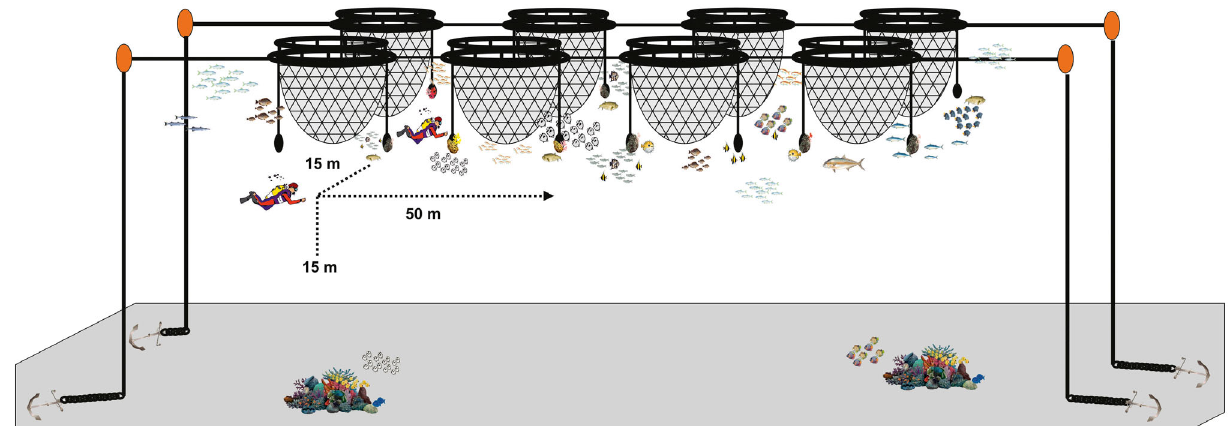
Fig. 2. Sketch showing 2 divers carrying out the underwater rapid visual census around fish cages at depths of 5 to 12 m, with the water column scanned from surface to bottom of adjacent cage (extension of census volume indicated). The sandy seafloor in this area has few solid substrates (e.g. concrete moorings or debris associated with the fish farms, shown in the sketch) and there were no coral reefs near the fish